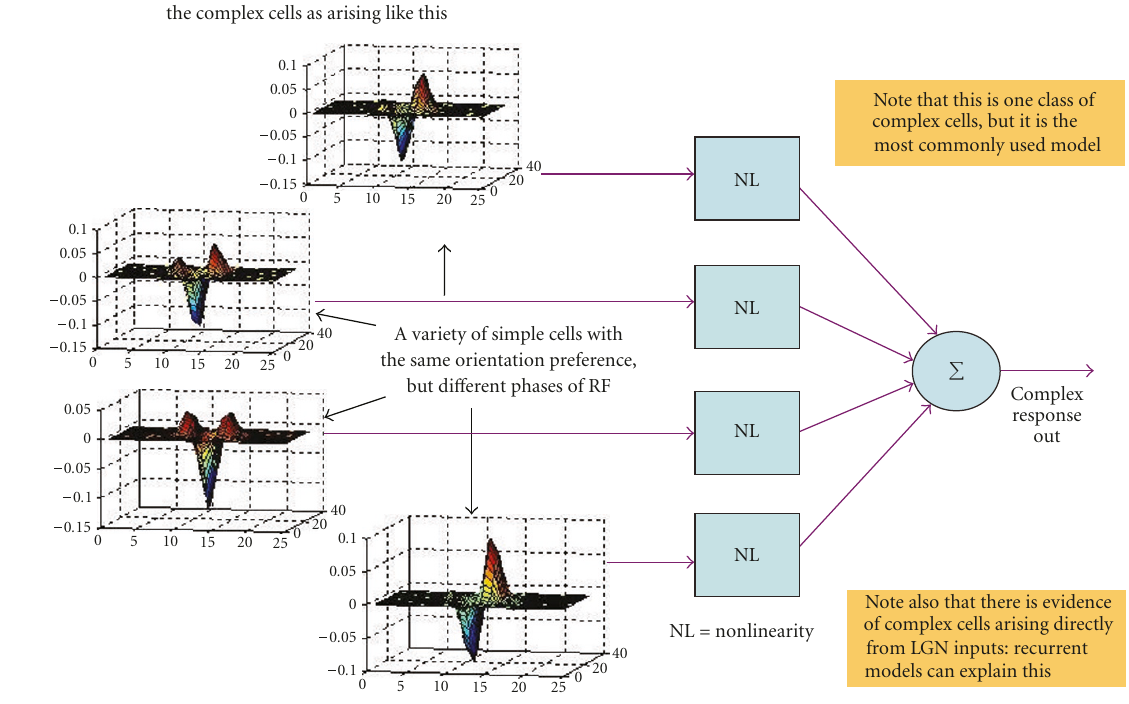
Figure 9: Generalized use of nonlinear combination of receptive fields over linear parameter variation to construct invariant feature measure. Note that the number of linear filters depends on parameter characteristics and sharpness of its tuning. For phase-invariant responses from quadrature filters, this reduces to two linear